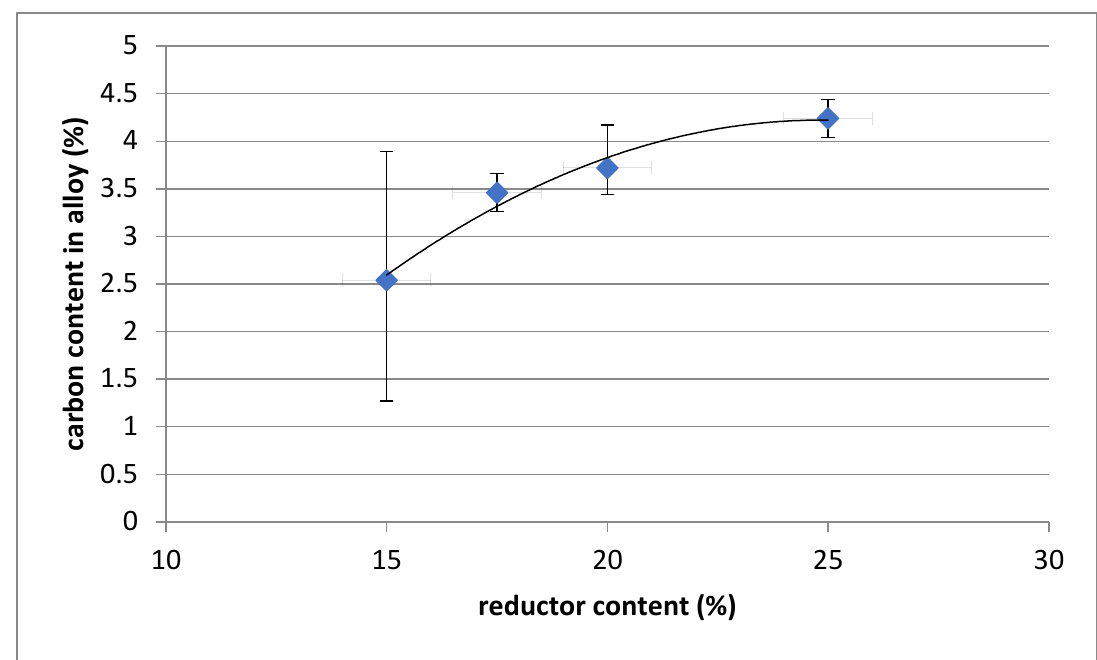
Figure 5. Dependence of the carbon content in the alloy on the content of reductor.